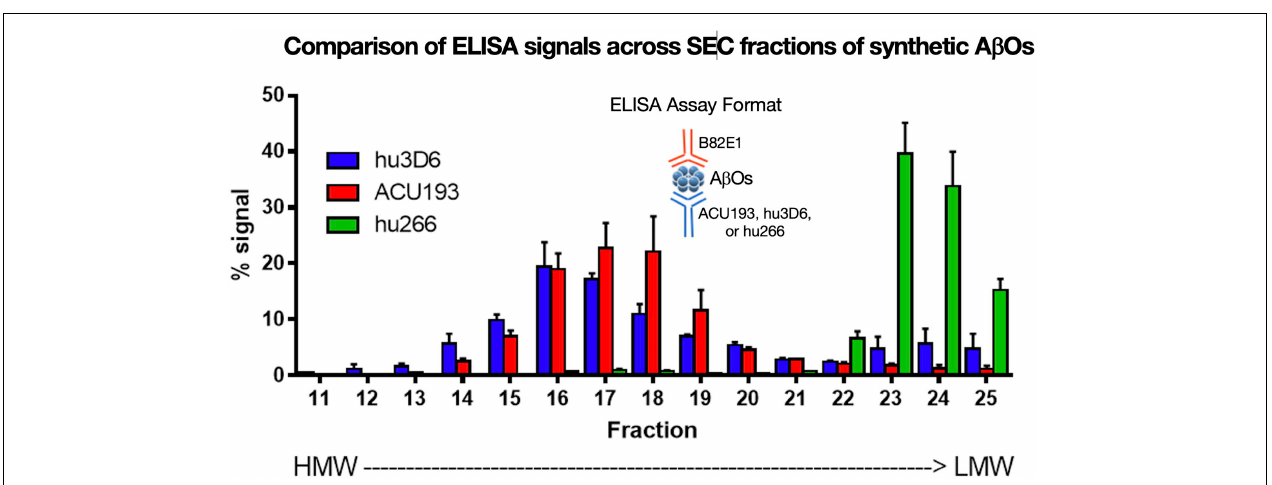
FIGURE 6 | Binding of humanized antibodies to SEC fractions of synthetic A β Os (ADDLs – Lambert et al., 1998; Chromy et al., 2003; Hepler et al., 2006). SEC fractionation of A β Os with sandwich ELISA detection (Savage et al., 2014). Hu3D6 is also known as bapineuzumab; hu266 is also known as solanezumab. These data demonstrate the specificity of ACU193 for oligomers versus monomers, and also demonstrate the ACU193 is capable of binding A β Os ranging from dimers to higher order structures up to several hundred